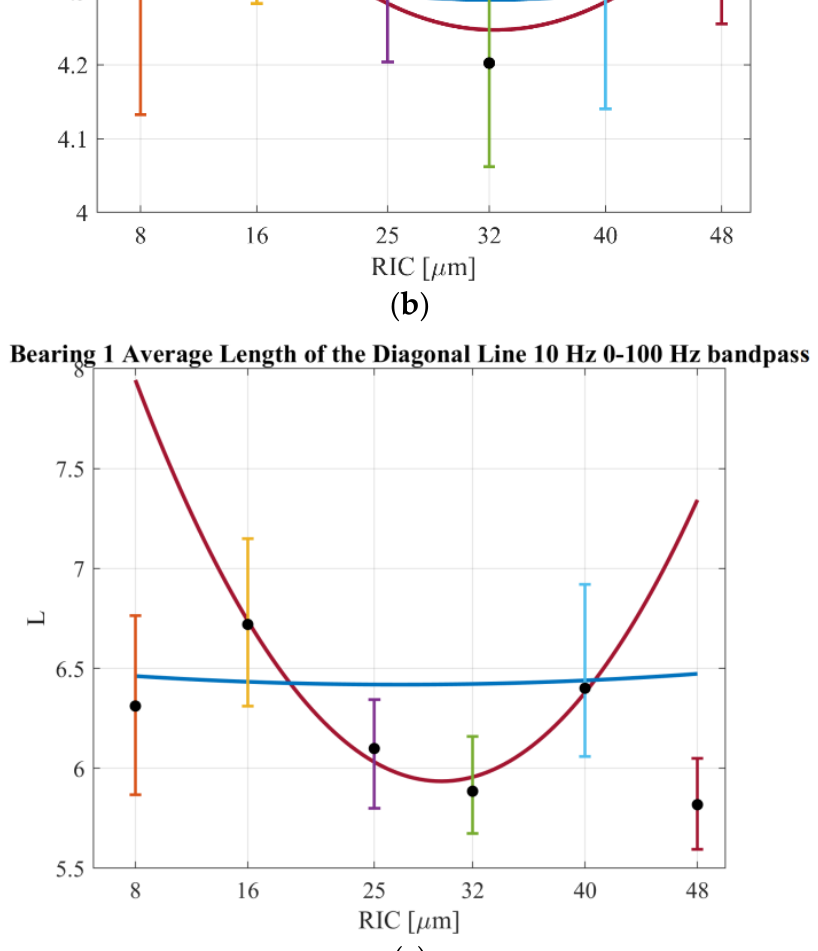
Figure 11. Results of the recurrence quantificators for the results obtained from the experiment for Bearing 1: ( a ) Entropy —ENTR , ( b ) Trapping Time— TT , ( c ) Average length of the diagonal line— L [20]. The blue line refers to the entire range of considered clearance values, while the red cubic function refers to the fitting to four middle clearance values.